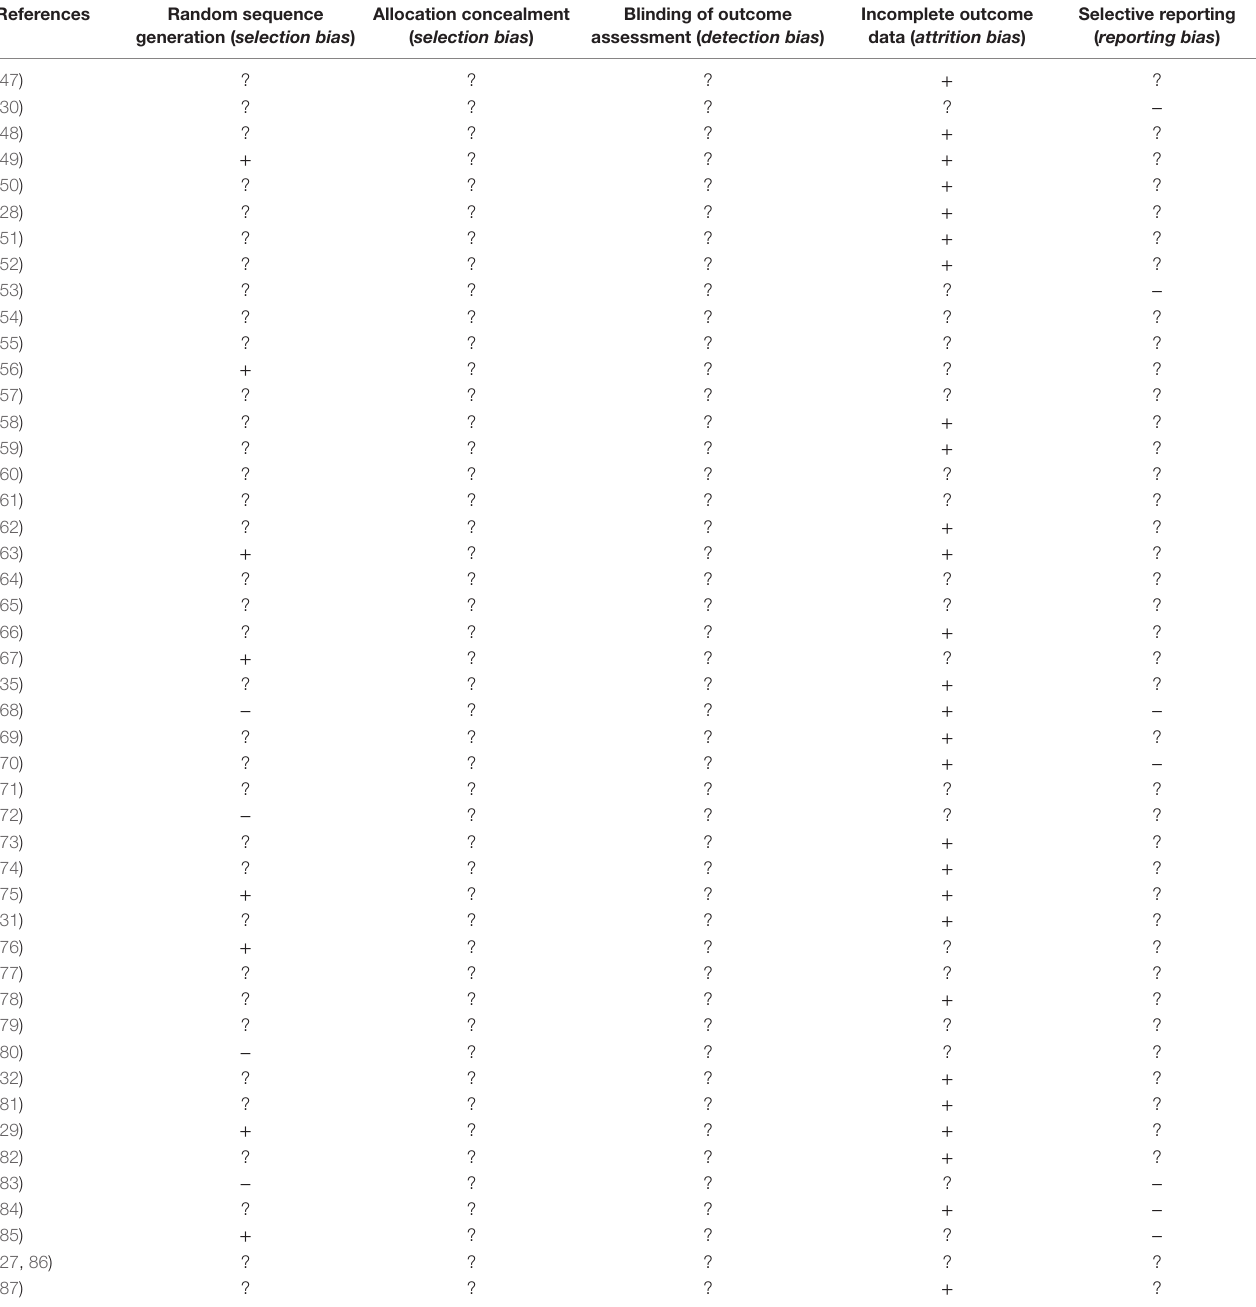
TABLe 3 | Risk of bias